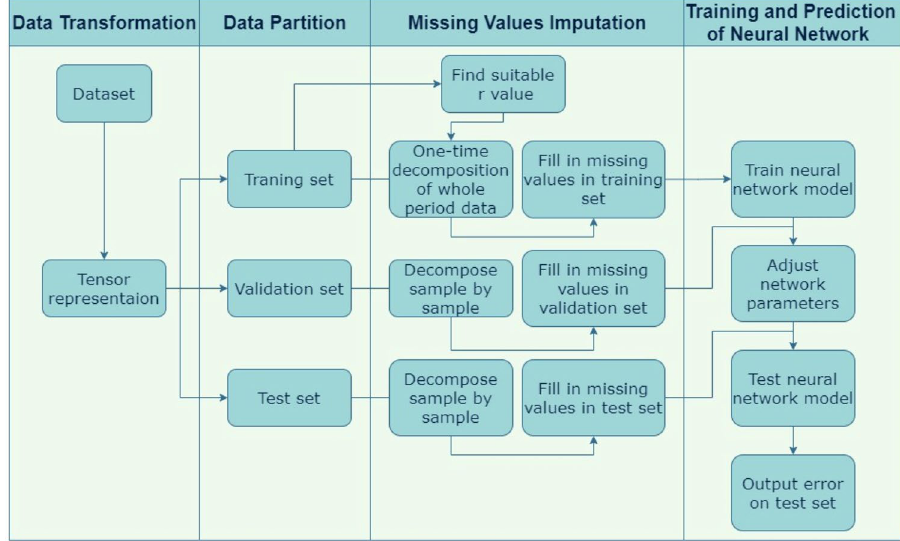
Fig. 5 Application process of BGCP-RNN